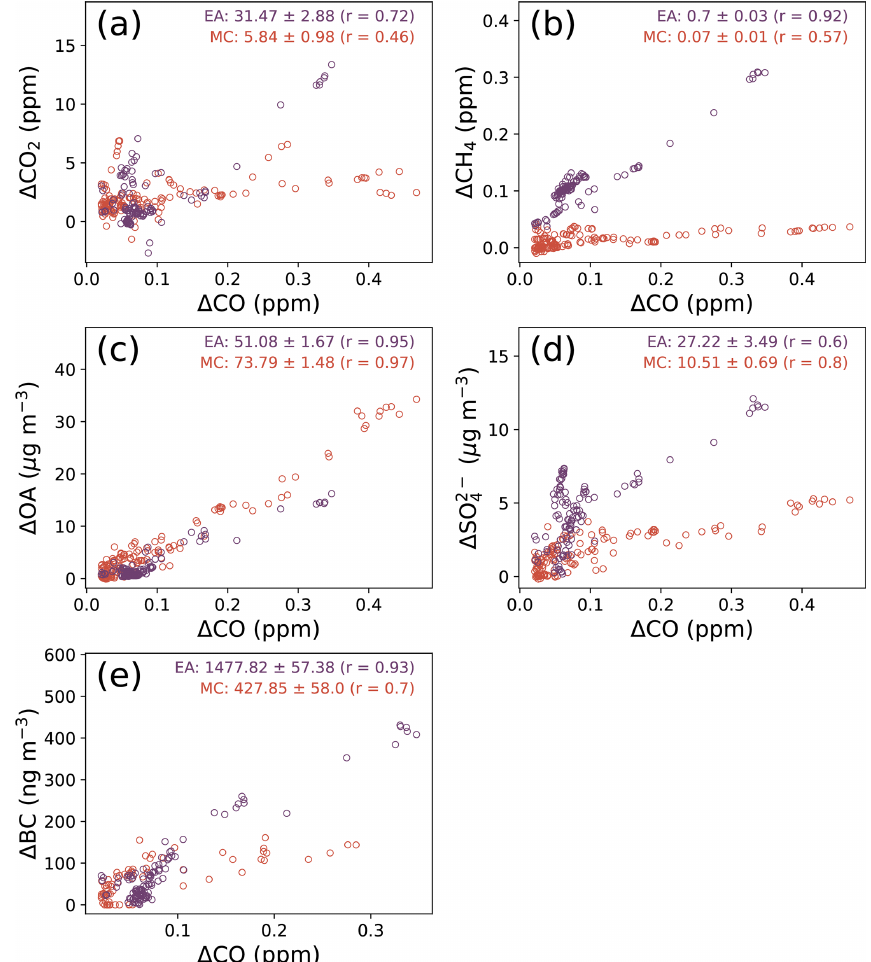
/(cid:49) CO, and (e) (cid:49) BC /(cid:49) CO for the Maritime 4